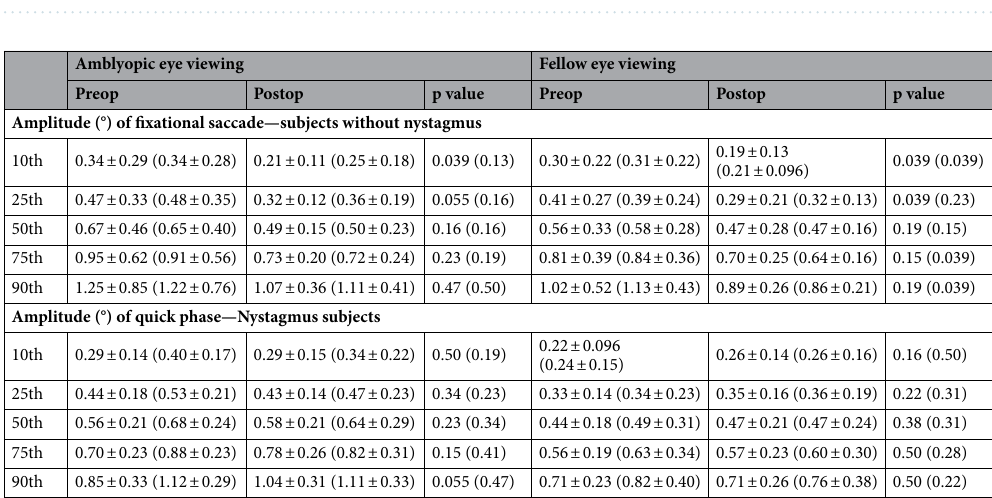
Table 2. Percentile amplitude (°) of fixational saccades in viewing eye and non-viewing eye (non-viewing eye in parenthesis) of subjects without and with nystagmus, before and after strabismus repair.